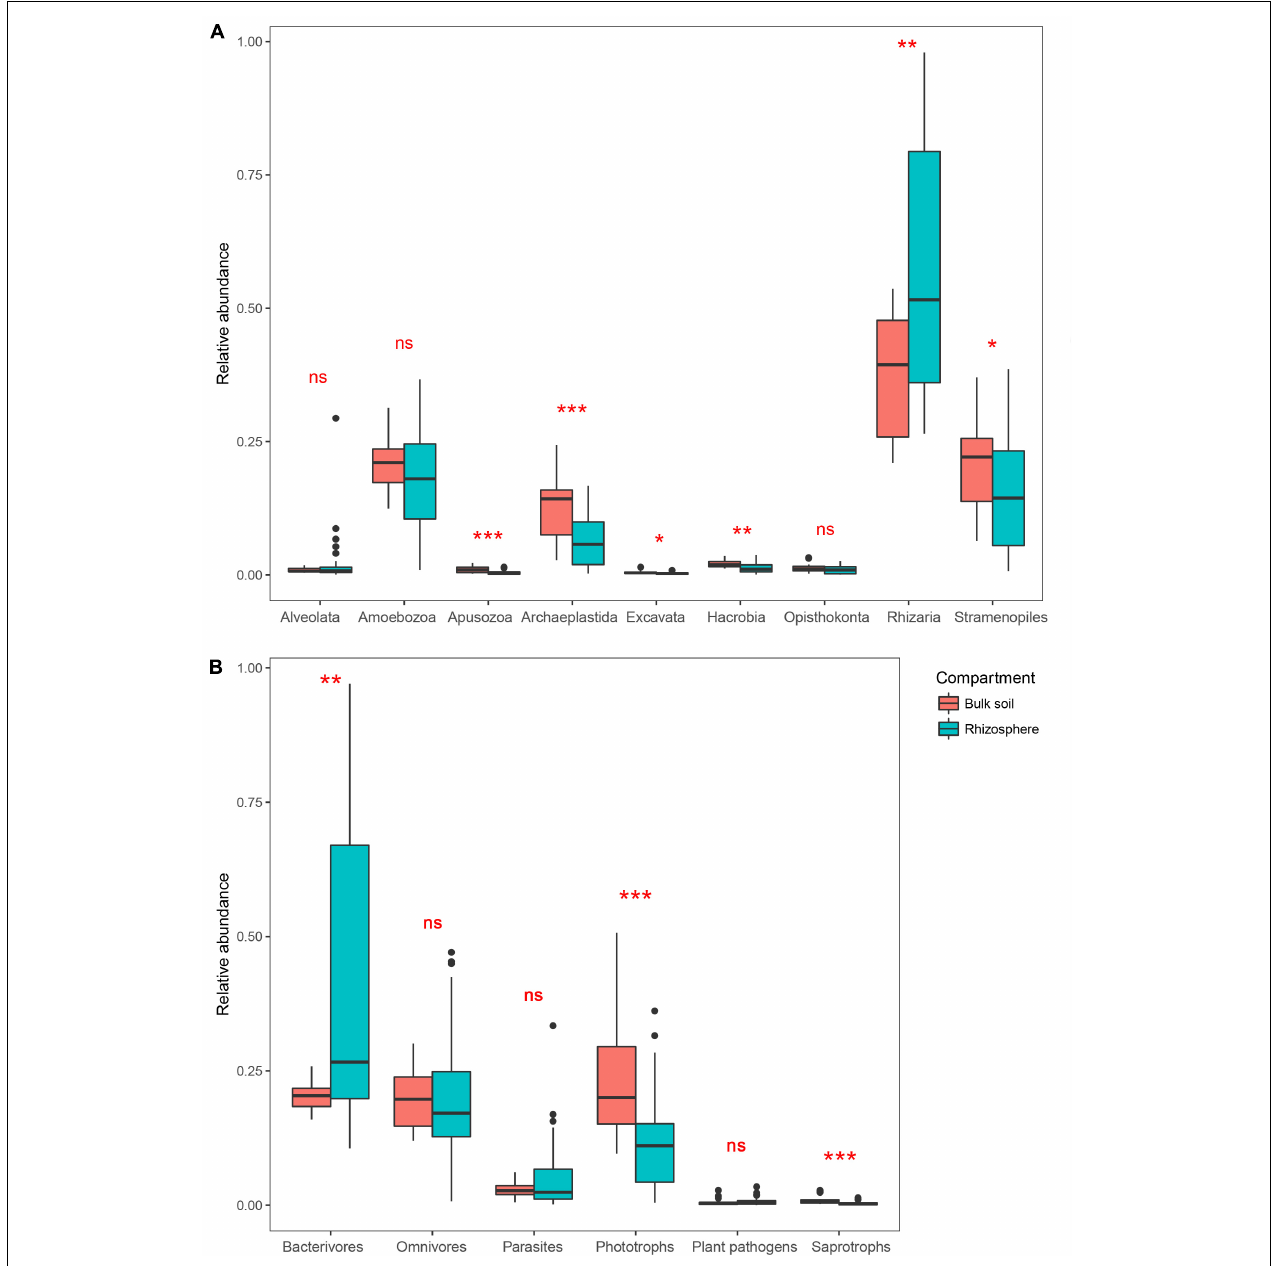
FIGURE 1 | Boxplots showing mean ( ± SE) relative abundances of five main protist taxonomic groups (A) and protist functional groups (B) in the bulk soil ( n = 18) and rhizosphere ( n = 54) of soybean fields in China. Statistical differences were analyzed using the Wilcoxon tests: *** P < 0.001, ** P < 0.01, * P < 0.05, and ns denotes a non-significant